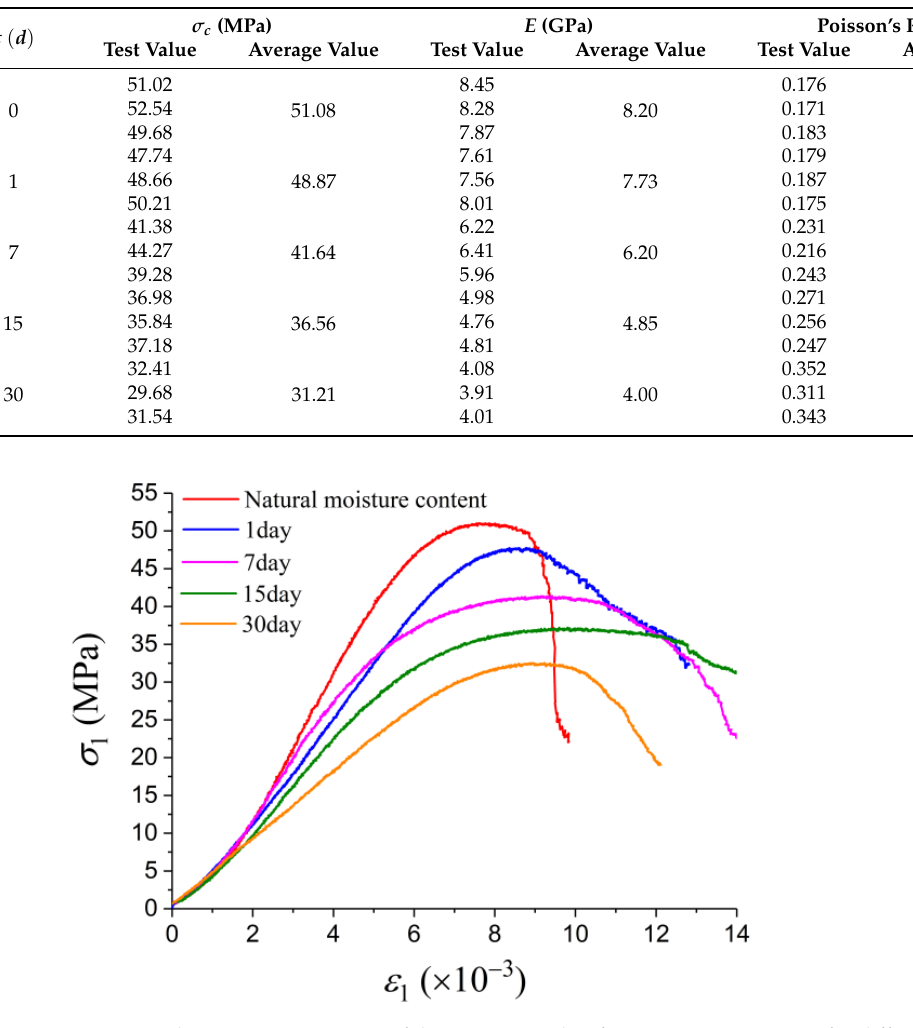
10 of 17 Figure 7. ( a ) The relationship between the fractal dimension/degree of damage and the water im- mersion time. ( b ) The relationship between the fractal dimension/degree of damage and the water content. 3.3. The Analysis of Strength and Deformability The mechanical parameters of the gypsum rock obtained from the triaxial compres- sion test are presented in Table 3 and the stress-strain curves are displayed in Figure 8. Table 3. The mechanical parameters of the gypsum rock obtained from the triaxial compression tests. Sample Number